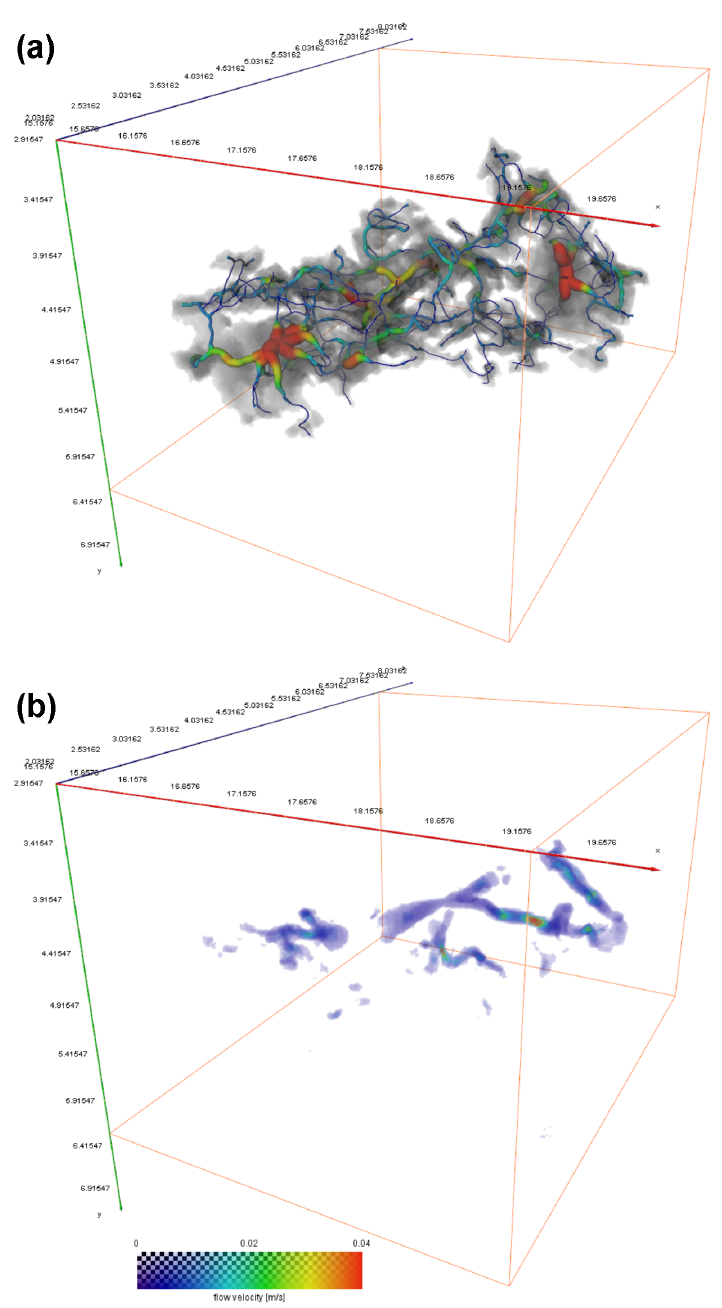
Figure 3. Orange pore cluster from sample WIC (see Fig. 2 for location). (a) skeleton transformation of the cluster. Colors represent relative thickness of the pore at that position (blue – thin; red – thick). (b) Velocity field of the GeoDict calculations in z direction for air as flowing phase. It is shown that only little of the total pore cluster participates in phase flow. Velocities increase in regions that form thin